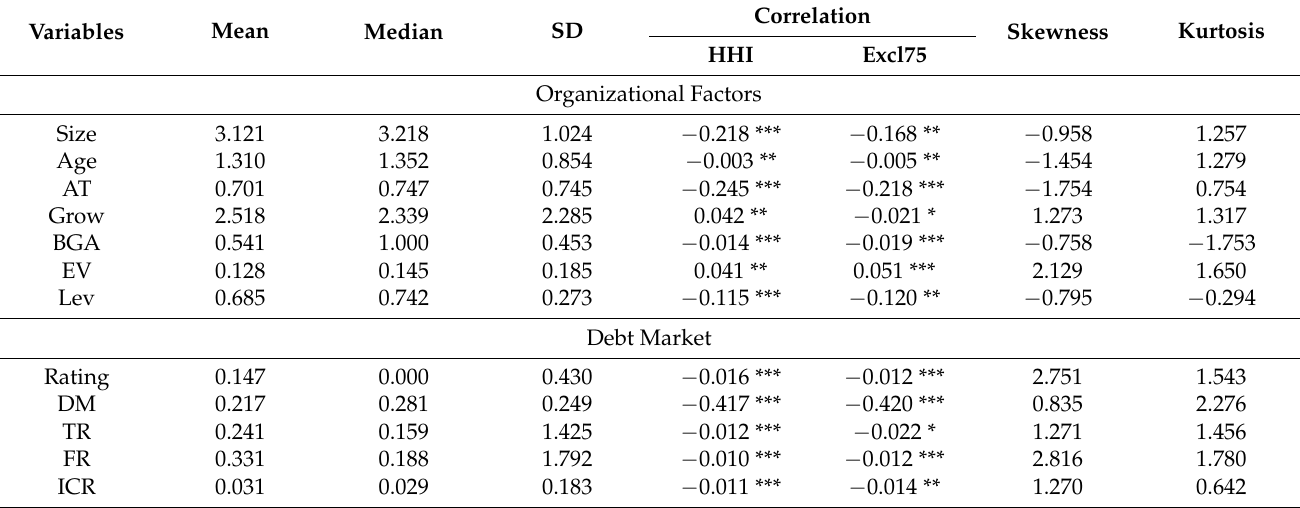
Table 2. Descriptive statistics.